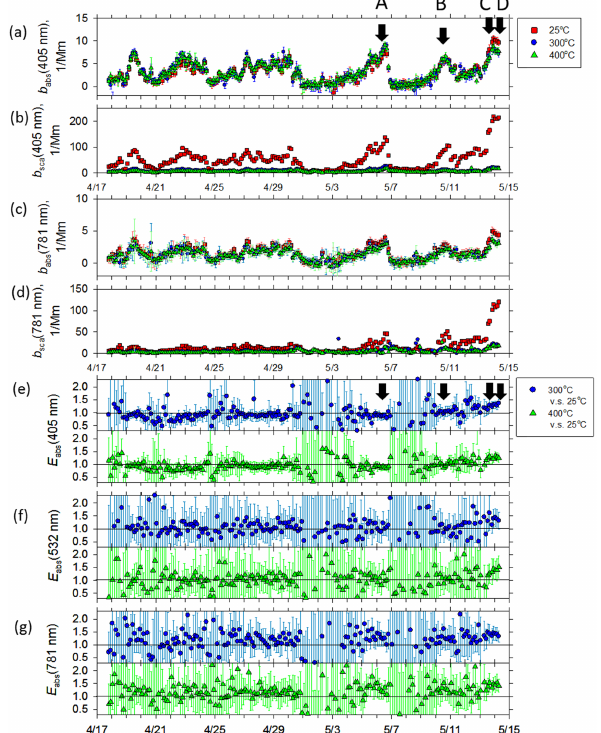
Figure 2. Temporal variations in (a) absorption coefficients at 405nm and start times of TEM sampling (A–D with arrows), (b) scattering coefficients at 405nm, (c) absorption coefficients at 781nm, (d) scattering coefficients at 781nm, and (e, f, g) enhance- ment of light absorption ( E abs ) at 405, 532, and 781nm, respec- tively. Red, blue, and green symbols in (a–d) represent conditions of 25, 300, and 400 ◦ C, respectively. Blue and green symbols in (e– g) represent E abs [= b abs (λ , 25 ◦ C) /b abs (λ , T ) ] with T = 300 and 400 ◦ C, respectively. The values are 3h averaged